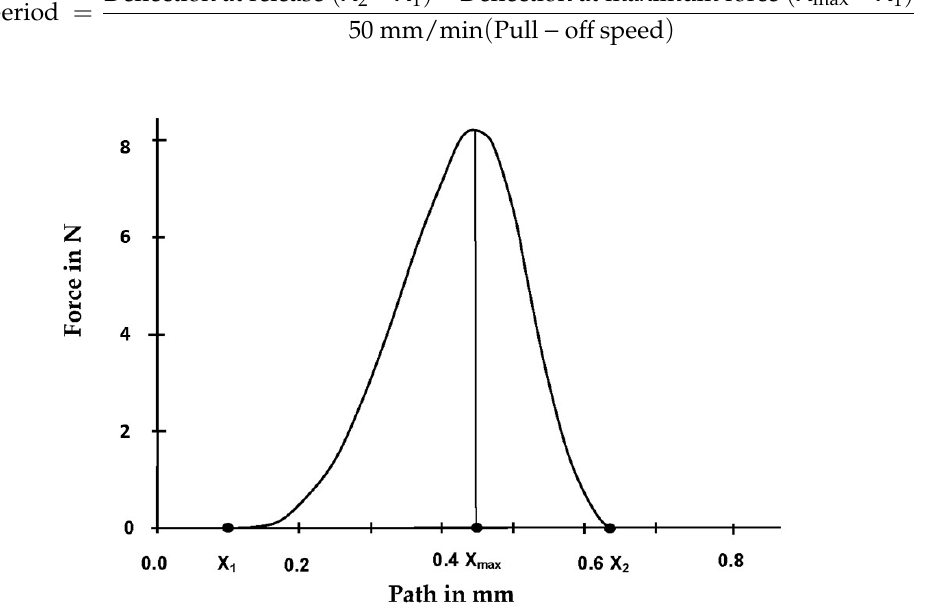
Figure3. Graphicalrepresentationofaretentionforcemeasurementwithanexampleforce-displacement diagram: implant angulation—0 ◦ with a Locator attachment system—5 ◦ and a pink Figure 3. Graphical representation of a retention force measurement with an example force- displacement diagram: implant angulation—0° with a Locator attachment system—5° and a pink matrix.